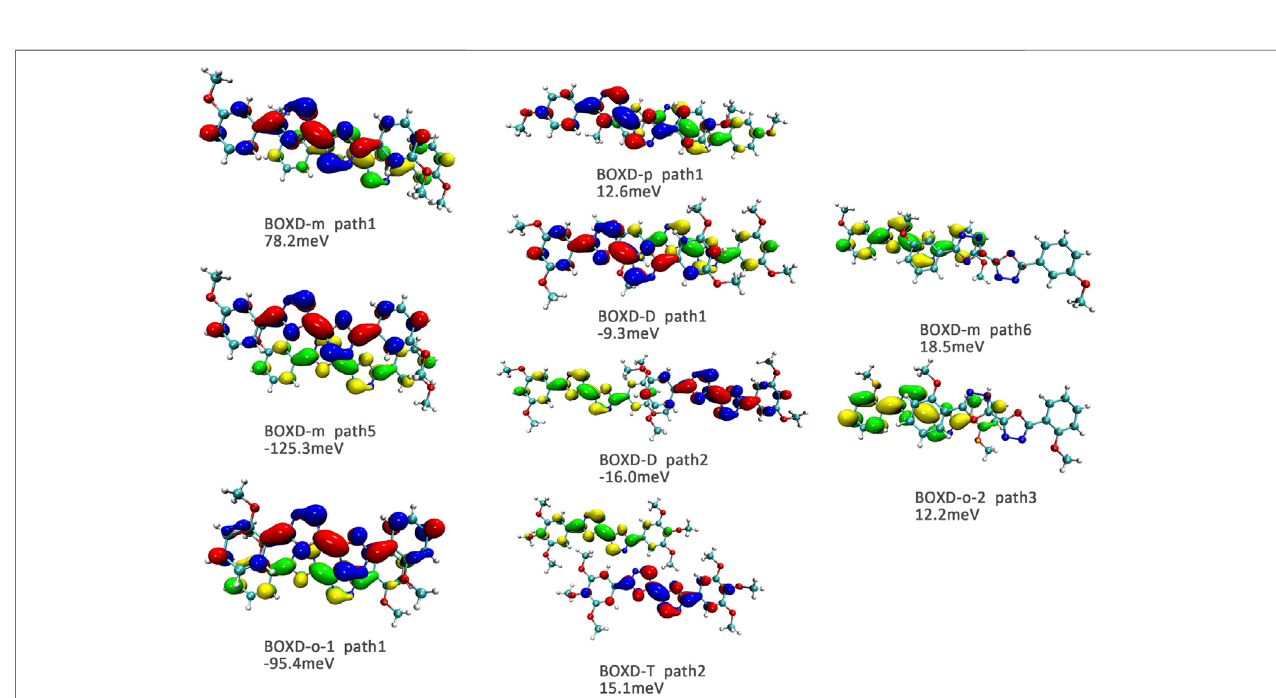
FIGURE5| Bimolecularorbitaldistributionofprimaryelectrontransferpathsin π stacking.Thepositivephaseisdepictedinredandyellow,andthenegativephase is depicted in blue and green.